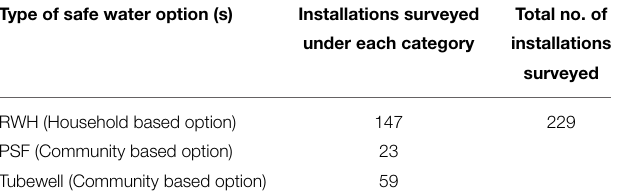
TABLE 3 | Type and number of safe water options